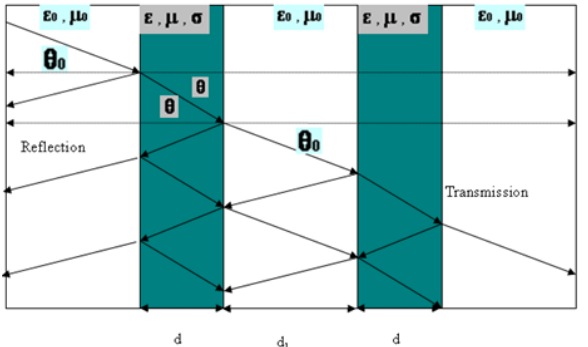
Figure 17. Multiple reflections from a changing propagation